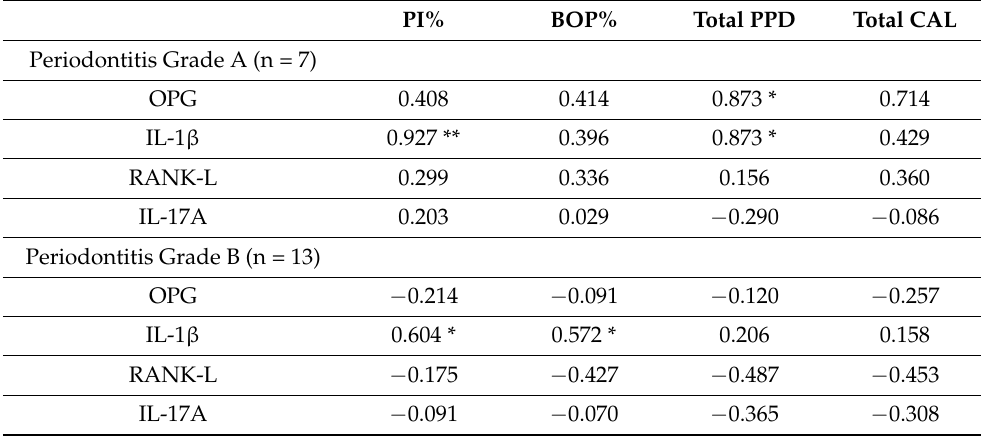
Table 6. Correlation between immunomediators and periodontal indices in patients with grade A, B and C